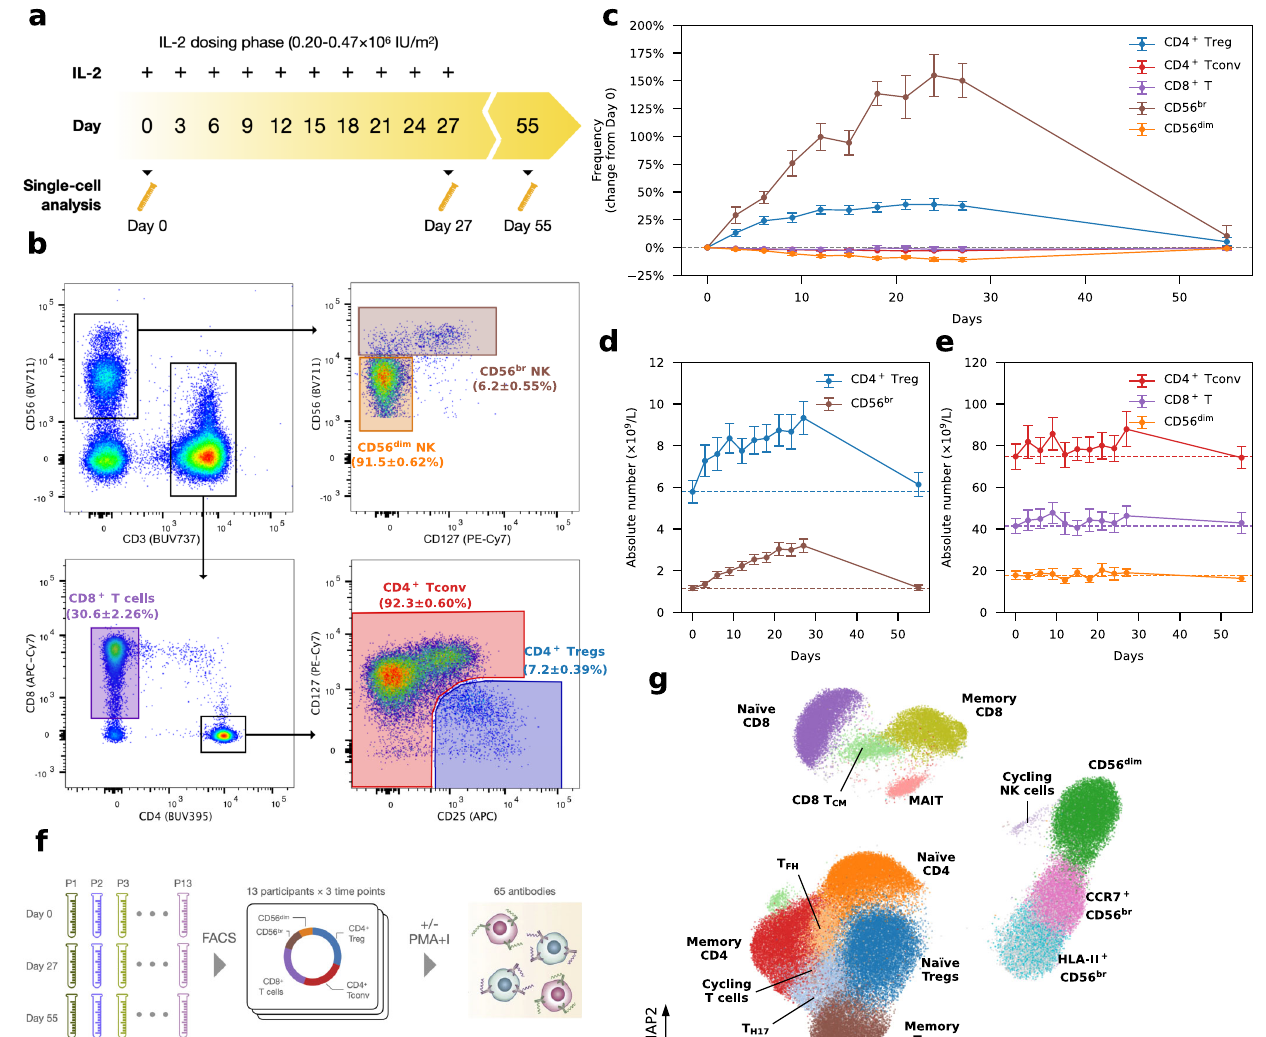
Fig. 1 | Interval low-dose IL-2 administered every three days sustained an increased frequency of CD4 + regulatory T cells and CD56 br NK cells in blood. a Schematic representation of the IL-2 dosing regimen used in this study. b Gating strategy for the delineation of the fi ve T and NK cell populations assessed by fl ow